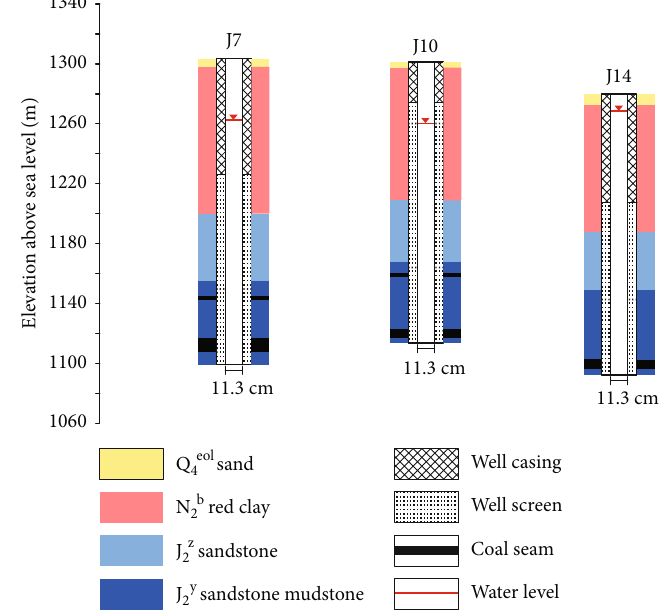
Figure 3: Well construction